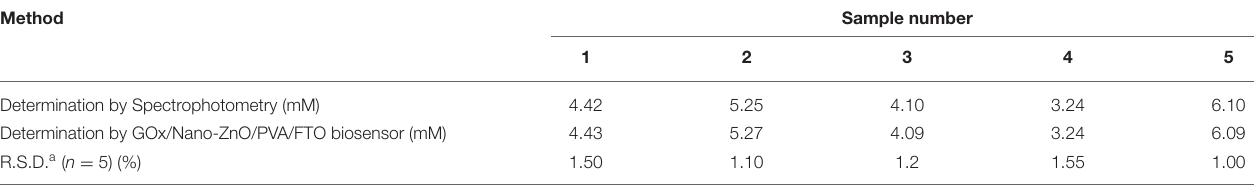
TABLE 1 | Measurement of the level of glucose in blood serum. Method